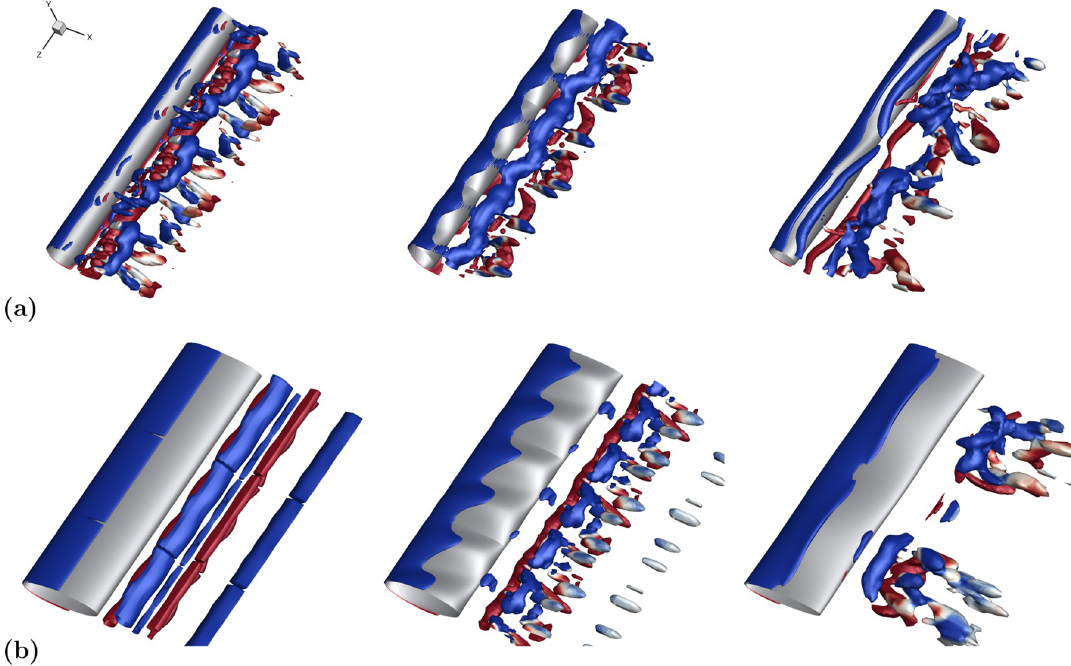
Fig 13. Flow structure comparison among various λ geometries. Isosurfaces of Q -criterion colored by positive (red) and negative (blue) spanwise vorticity show a larger wavelength allows for break up of flow structures while flow structures from low λ models continue to resemble those of their smooth cylindrical counterparts. (a) Circular geometries (low γ ); nondimensional Q -criterion value 1.6. From left to right: no undulations, CS2 (low λ ), CL2 (high λ ). (b) Elliptical geometries (high γ ); nondimensional Q -criterion value 0.8. From left to right: no undulations, ES2 (low λ ), EL2 (high λ ).